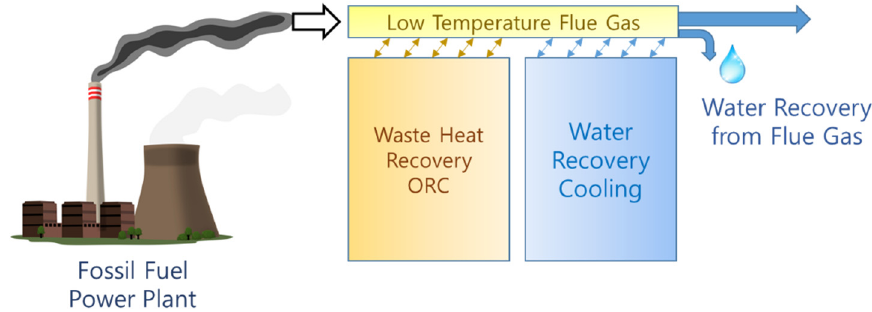
Figure 1. Schematic of a heat and water recovery system [18].